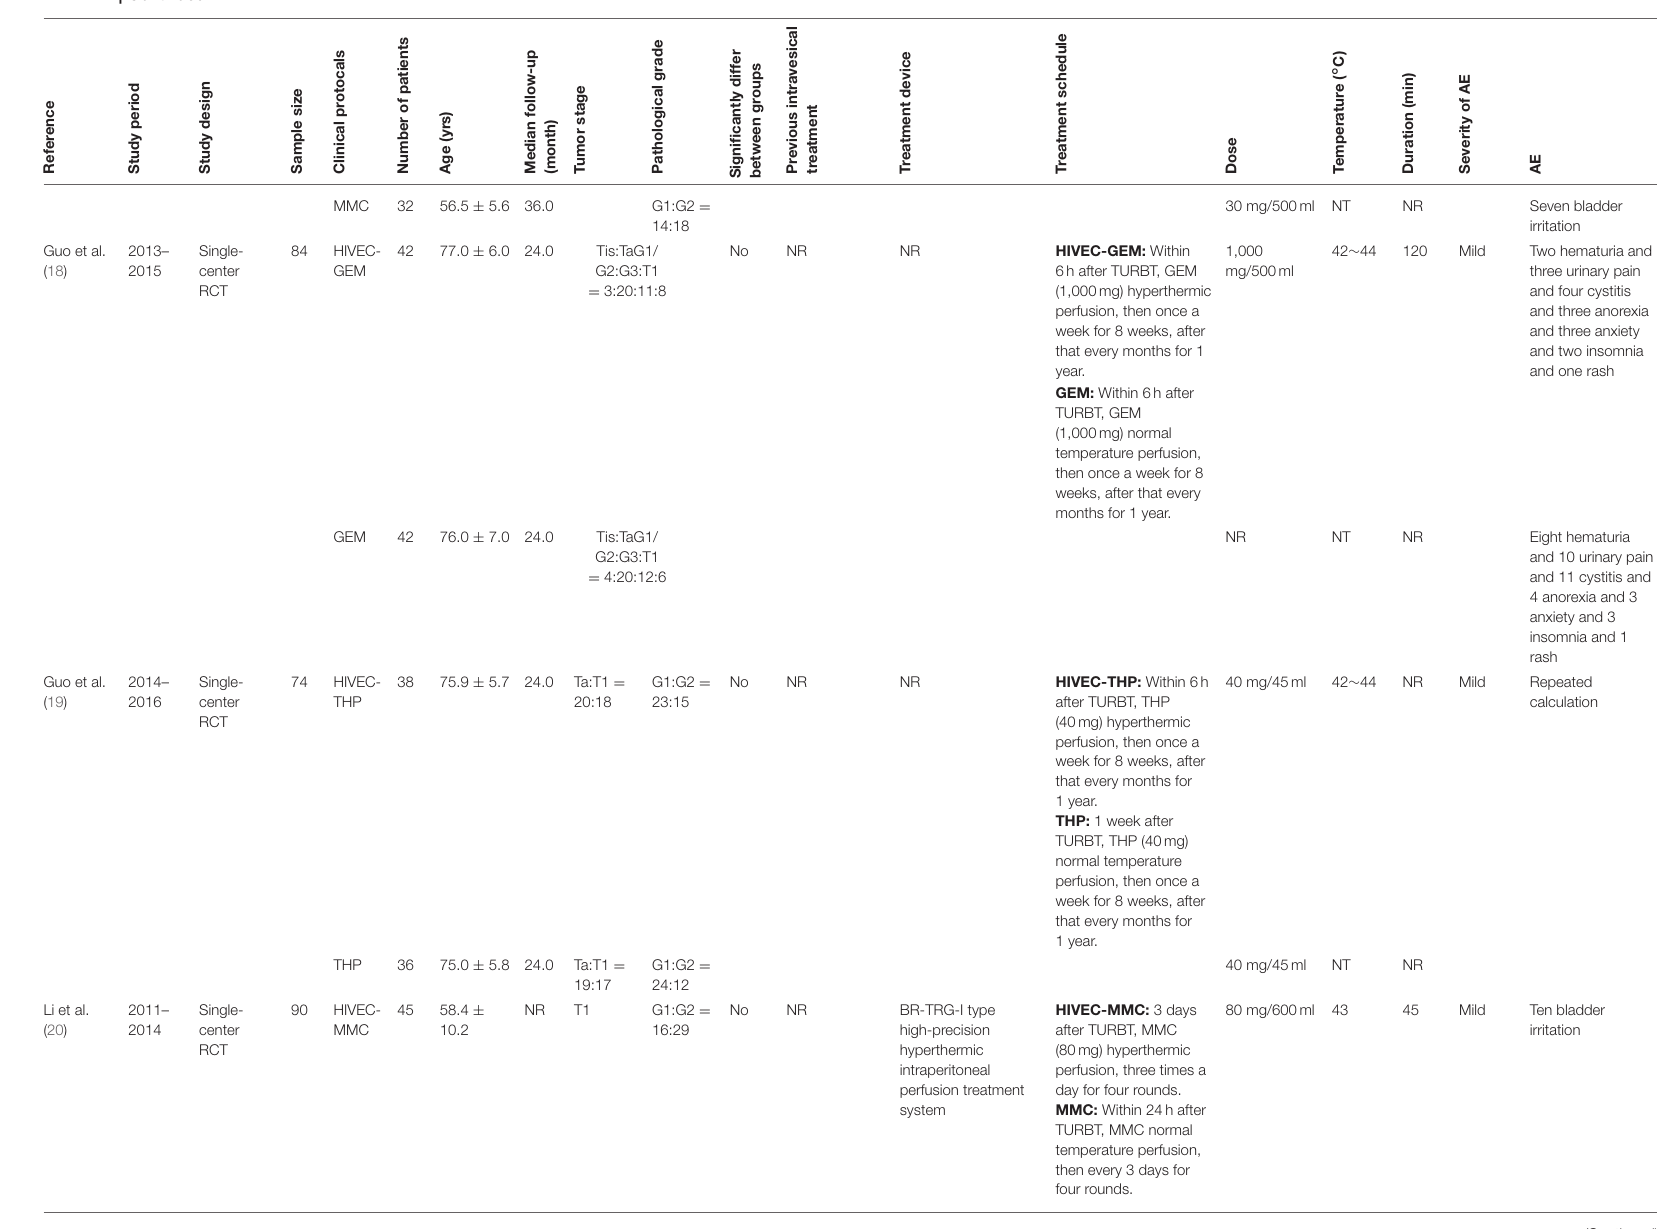
THP: 1 week after TURBT, THP (40mg) normal temperature perfusion, then once a week for 8 weeks, after that every months for 1 year.